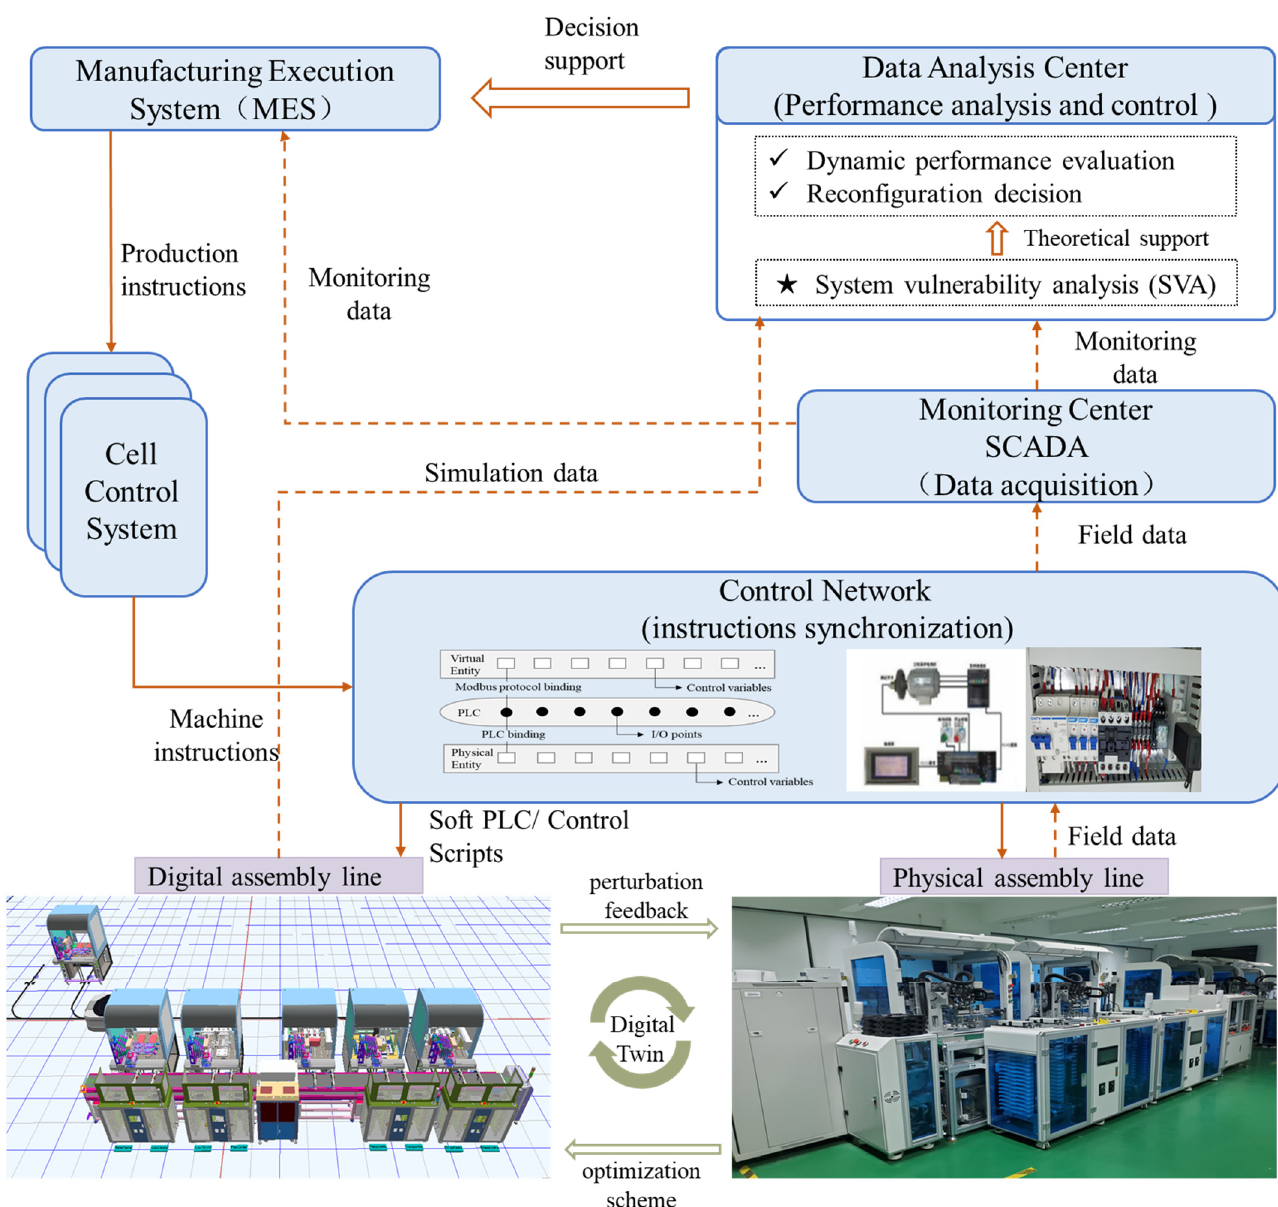
Figure 2. A digital twin system of disturbance evaluation and regulation.